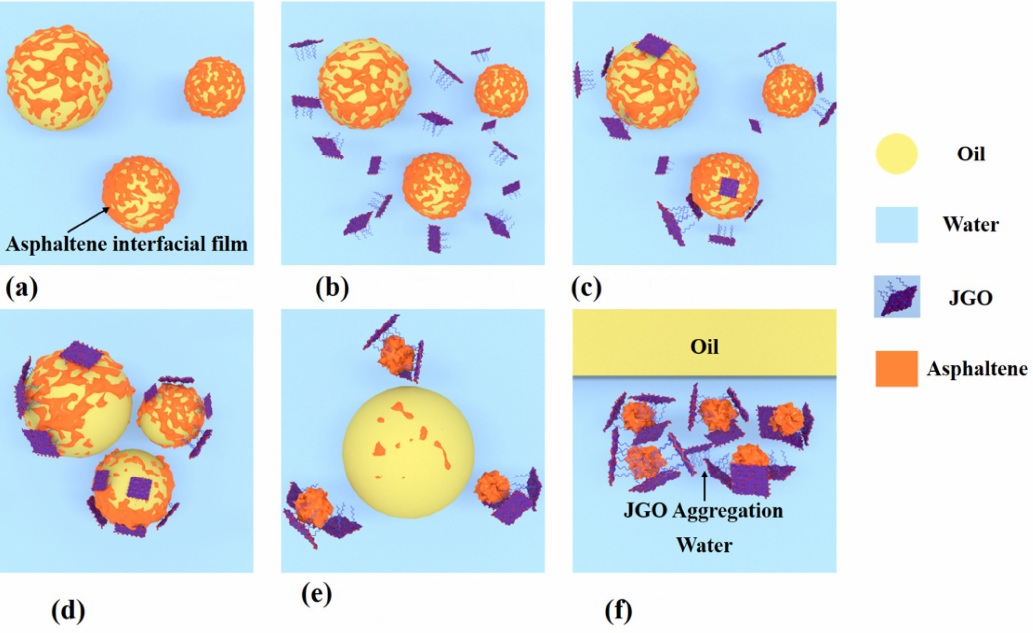
Figure 6. Schematic of the demulsification mechanism of JGO; ( a ) stable emulsion; ( b ) adding JGO; ( c ) adsorption of JGO; ( d ) shaking; ( e ) aggregation of oil droplets; ( f ) after